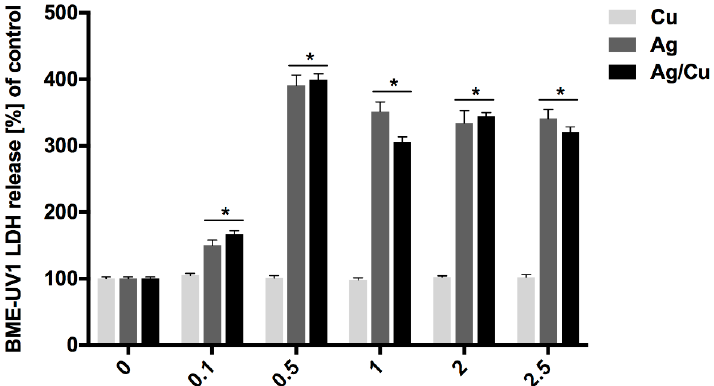
Figure 3. Membrane integrity of BME-UV1 cells (*—differences significant at p < 0.05).